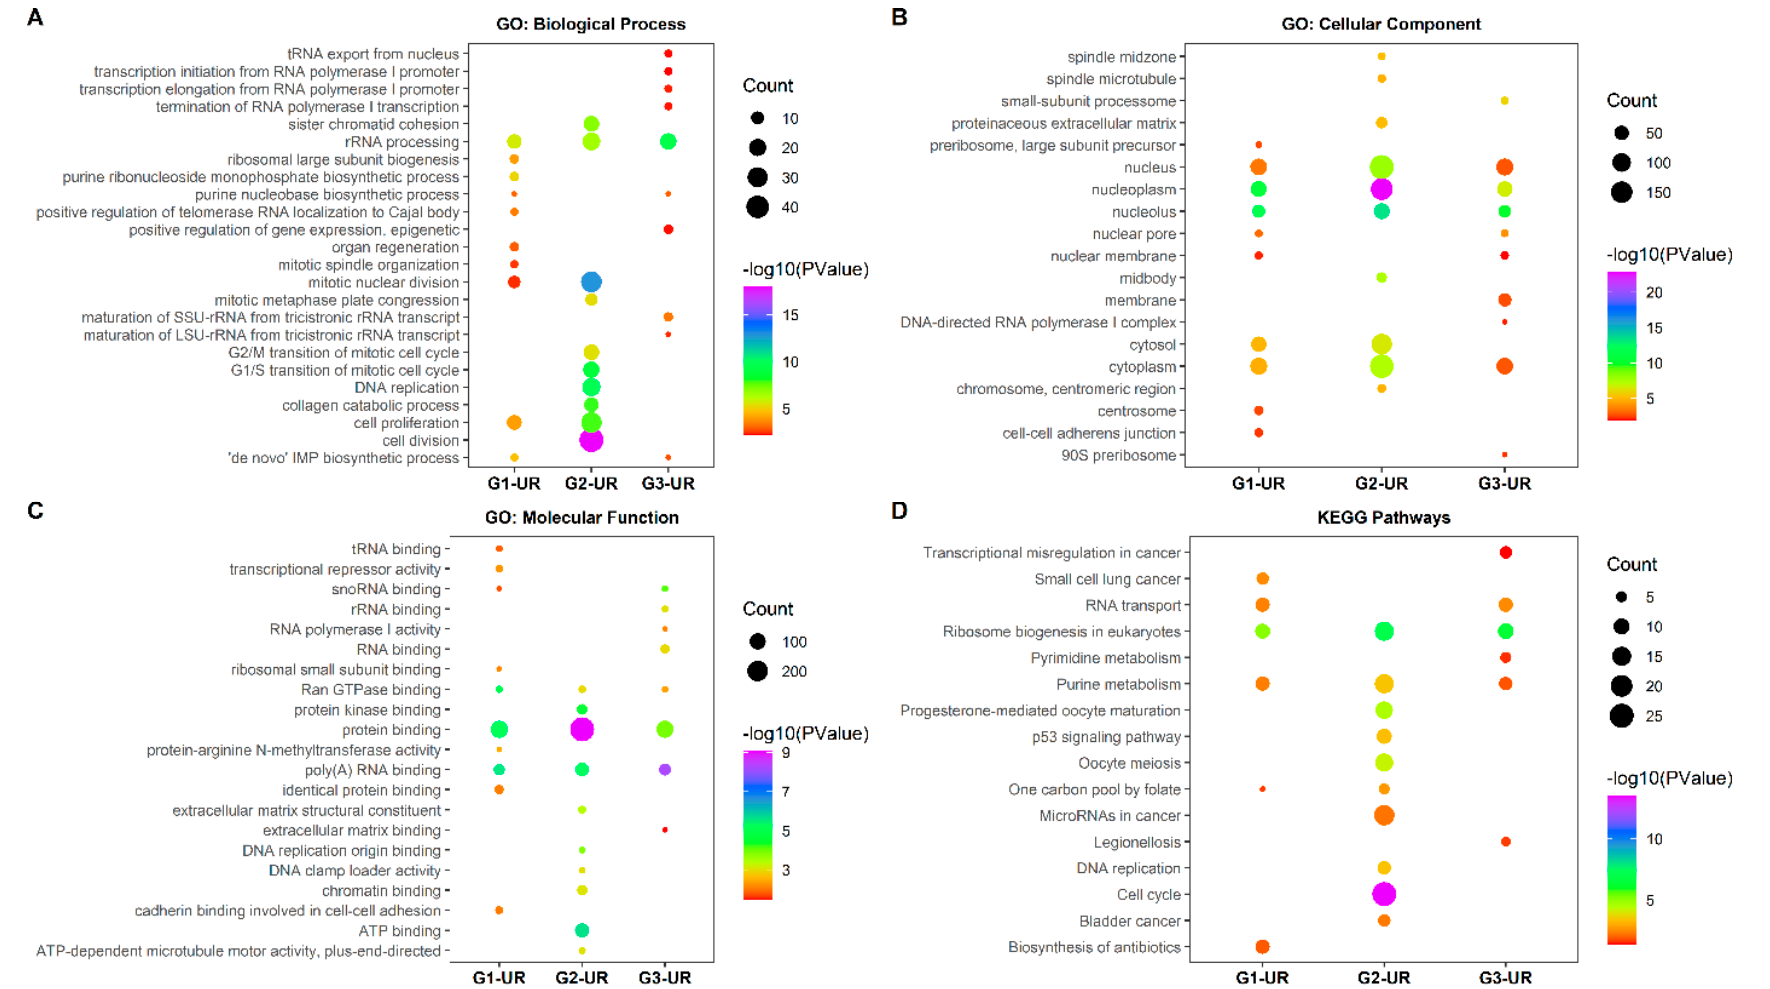
Figure 1. GO and KEGG pathway enrichment of RRA-UR genes. ( A ) GO enrichment of biological process. ( B ) GO enrichment of cellular components. ( C ) GO enrichment of molecular function. ( D ) KEGG pathway enrichment. Abbreviations: UR, Upregulated; GO, gene ontology; KEGG, Kyoto encyclopedia of genes and genomes.